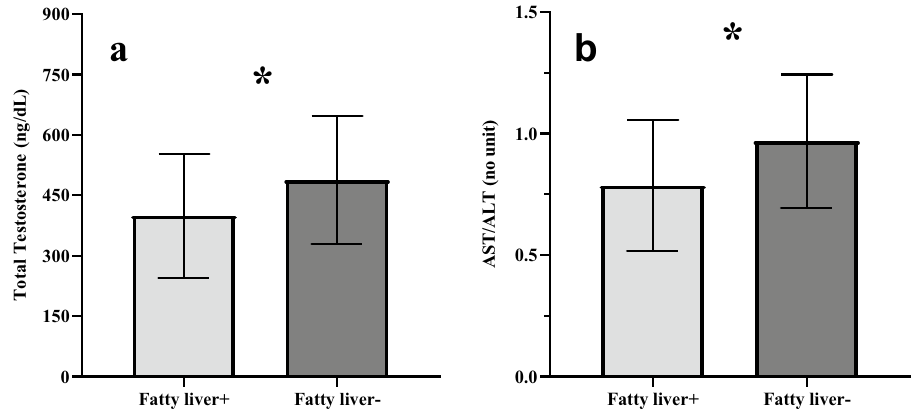
Figure 3. Serum total testosterone levels ( a ) and AST/ALT ratio ( b ) (mean ± SD) in firefighters with fatty liver (fatty liver + [n = 119]) and in those without it (fatty liver− [n = 179]). *p < 0.01 (T-test).